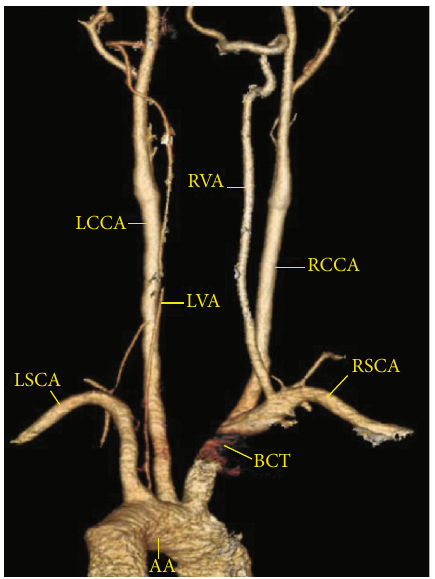
Figure 1: Three-dimensional reconstructed computed tomography angiography shows the carotid, subclavian, and vertebral arteries. A hypoplastic left vertebral artery originates from the aortic arch and is smaller than the right vertebral artery along its entire course. All mentioned vascular structures show normal caliber and course, smooth intima, and no narrowing or obliteration. AA = aortic arch; BCT = brachiocephalic trunk; LCCA = left common carotid artery; LSCA = left subclavian artery; RCCA = right common carotid artery; RSCA = right subclavian artery; LVA = left vertebral artery; RVA = right vertebral